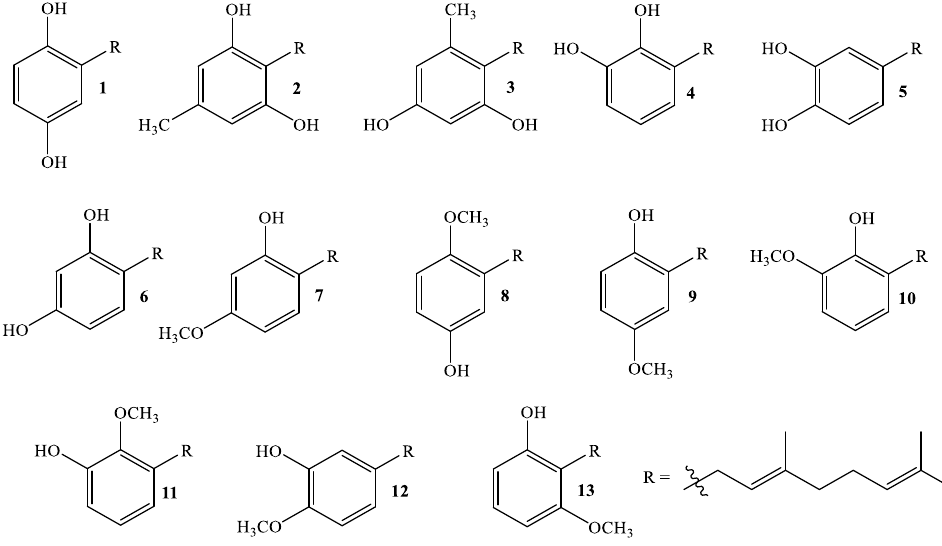
Figure 1. Structure of known linear geranylated phenols/methoxyphenols (Group I).